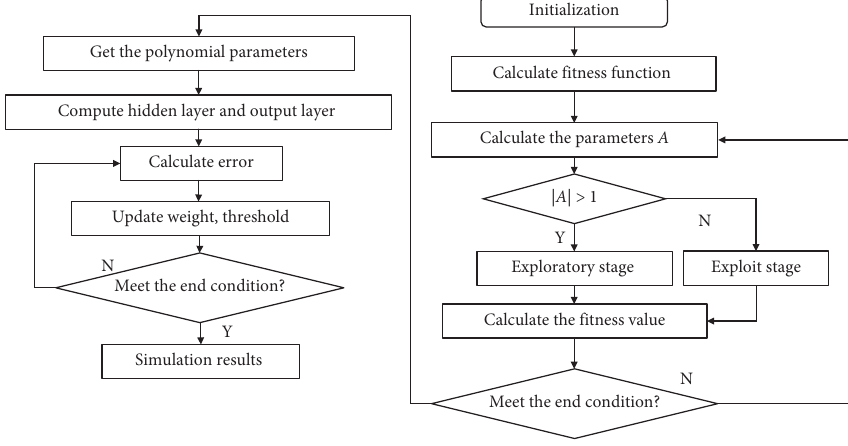
Figure 3: The flowchart of BP algorithm based on